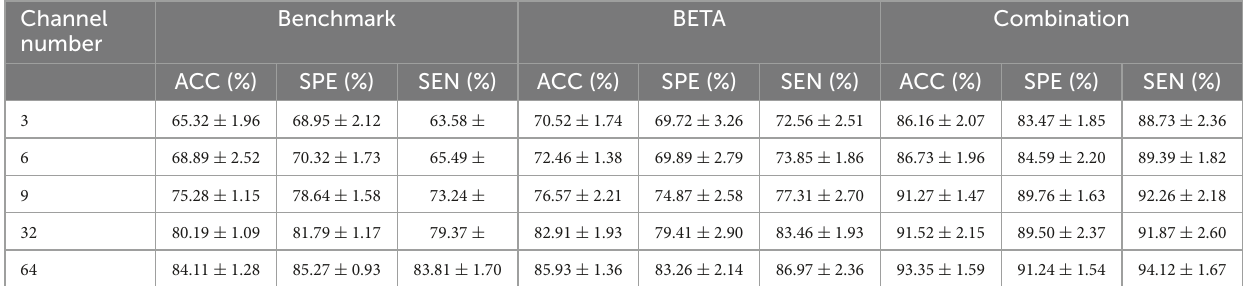
TABLE 2 Classification results (ACC, SPE, SEN, and their corresponding STDs) of our model is reported versus varying number of channels and 1.0 s of stimulation. Channel Benchmark BETA Combination number ACC